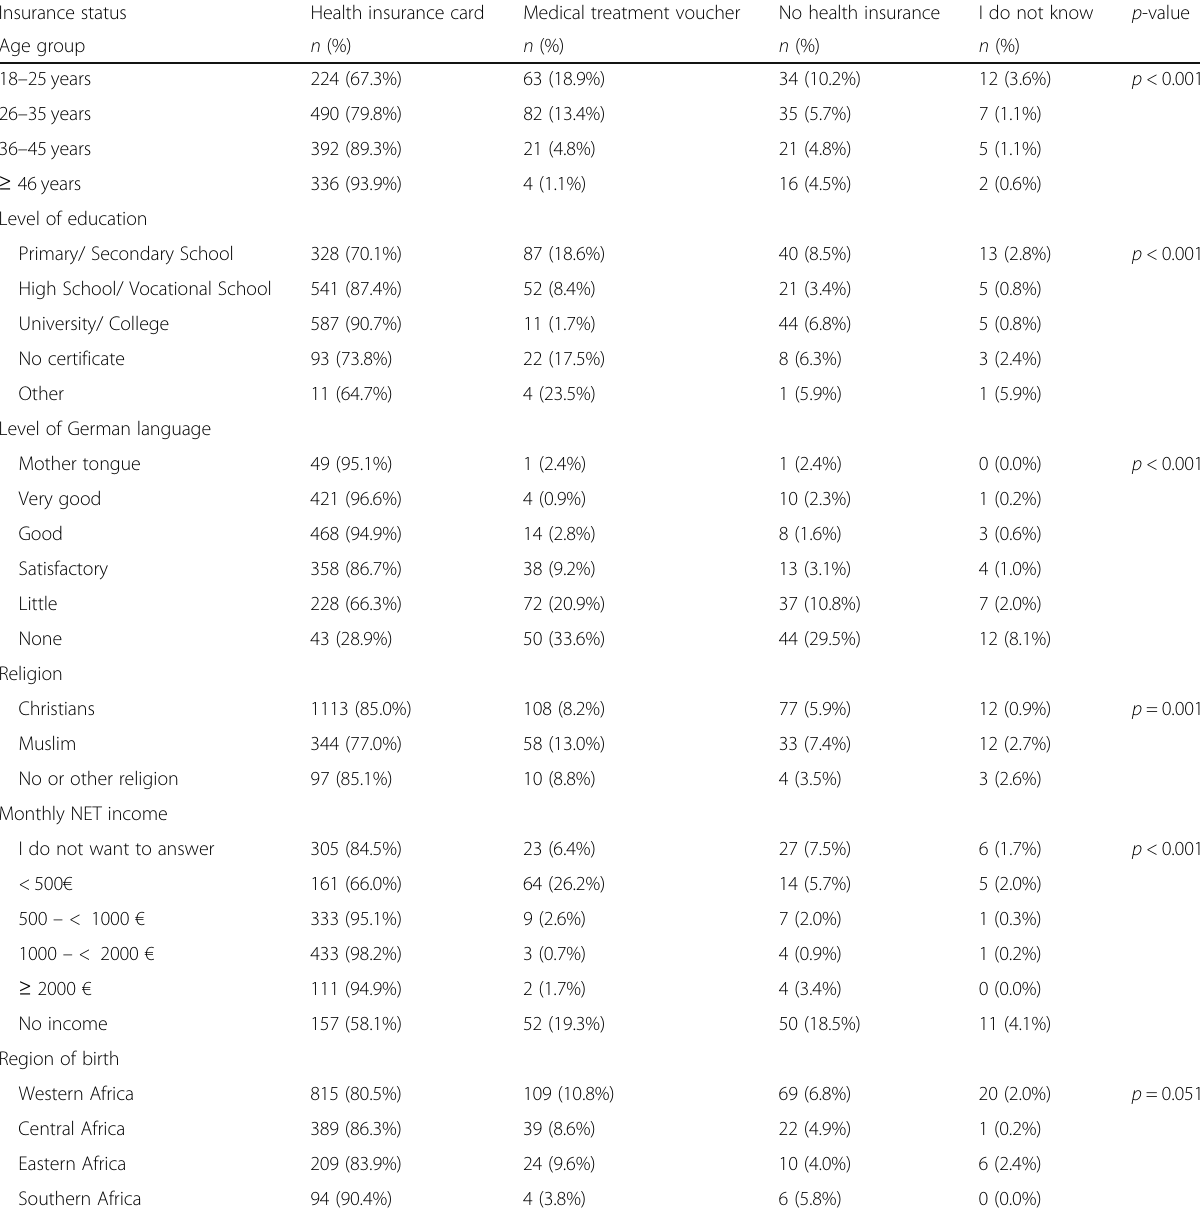
Table 2 Health insurance status and socio-demographic characteristics of the study population